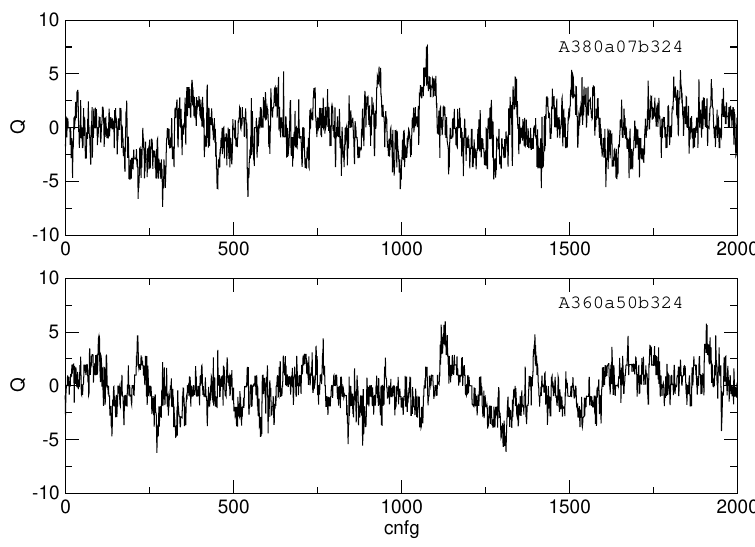
Figure 2 . History of the topological charge for two